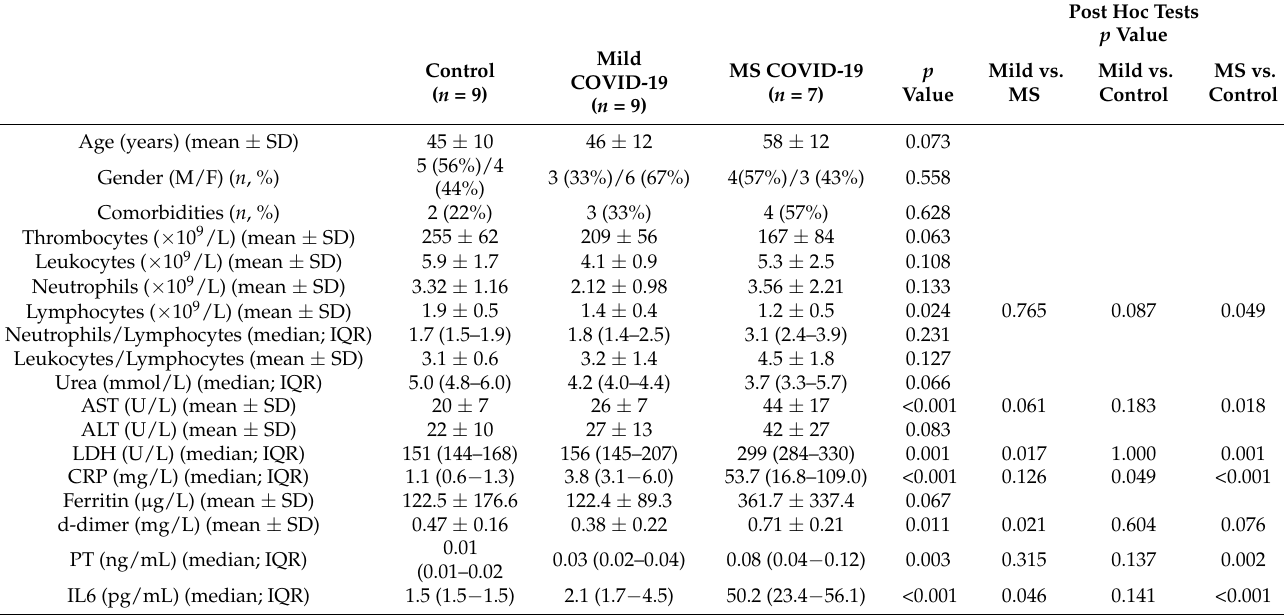
Table 2. Baseline characteristics of control, patients who had stable mild COVID-19, and stable moderate and severe COVID-19.